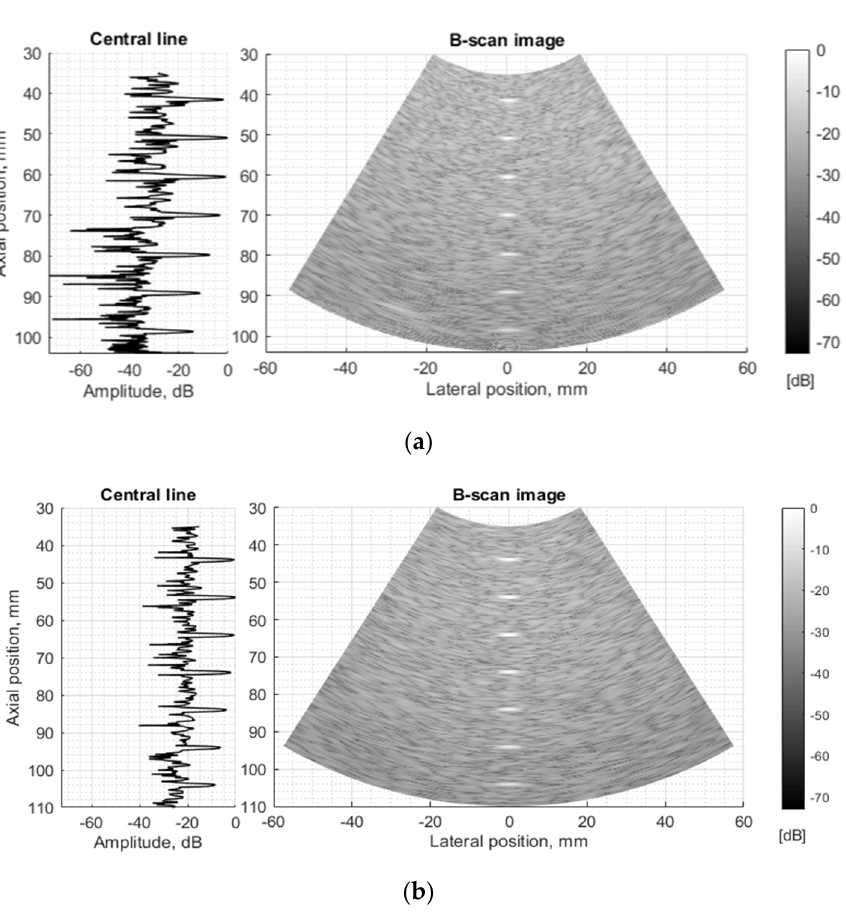
Figure 10. Comparison of envelopes of backscattered signals ( left ) and whole B-scan images ( right ) of ( a ) RF data measured in ATS Model 549 (physical wire phantom) ( b ) simulated RF data of digital wire target phantom.